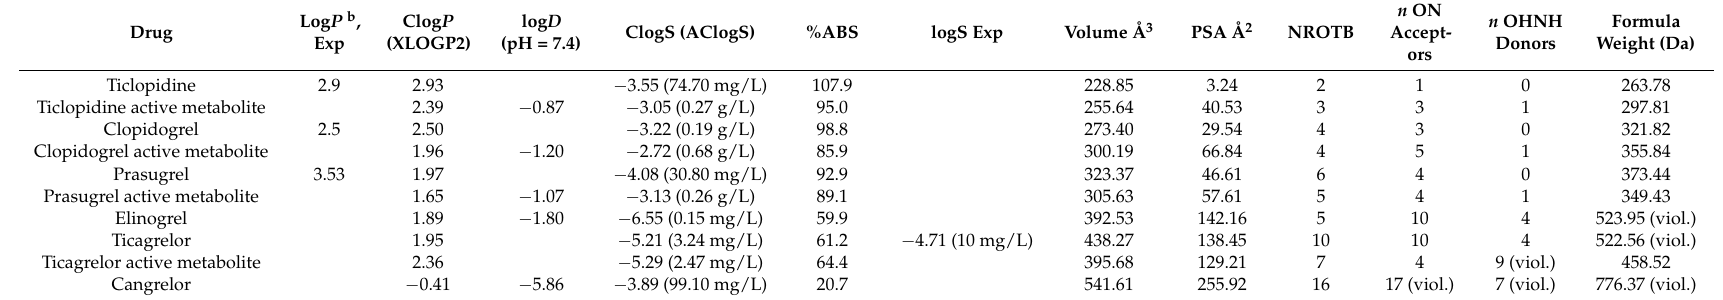
Table 5. Calculated lipophilicity (clog P ), solubility (clog S ), absorption (%ABS), polar surface area (PSA) and Lipinski parameters of the antiplatelet drugs studied a .